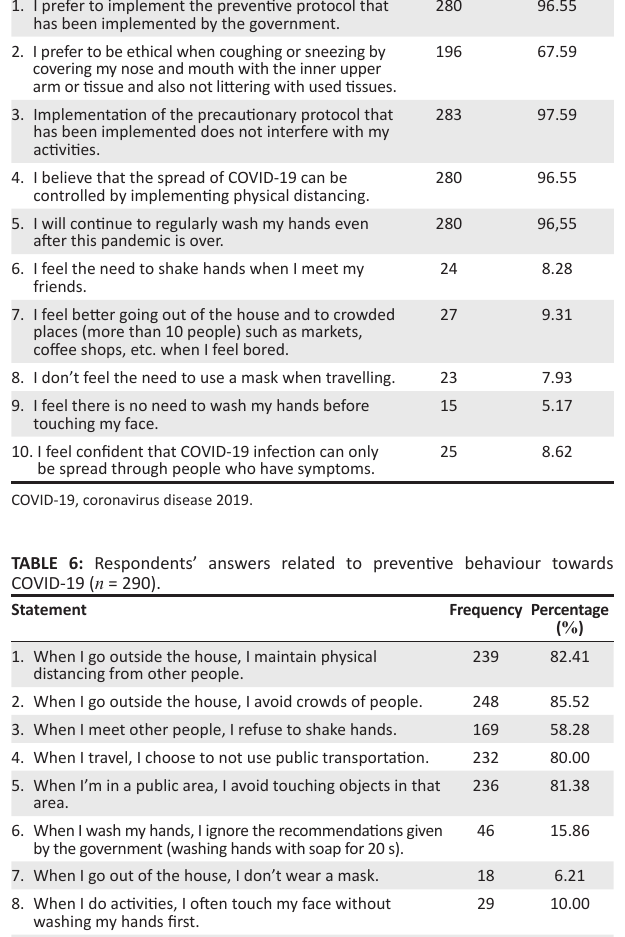
TABLE 5: Distribution of respondents’ answers where respondents agreed with statements related to attitude towards COVID-19 ( n = 290). Statement